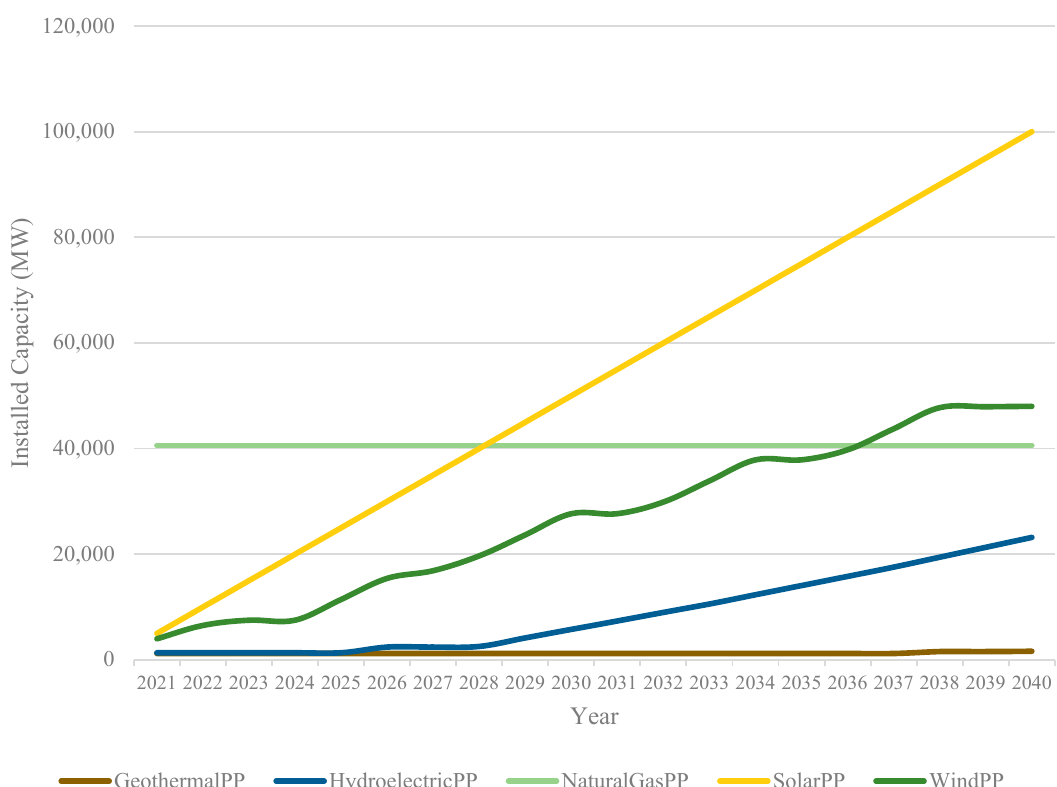
Figure 7. Installed capacities for the second scenario in the 2021–2040 horizon.